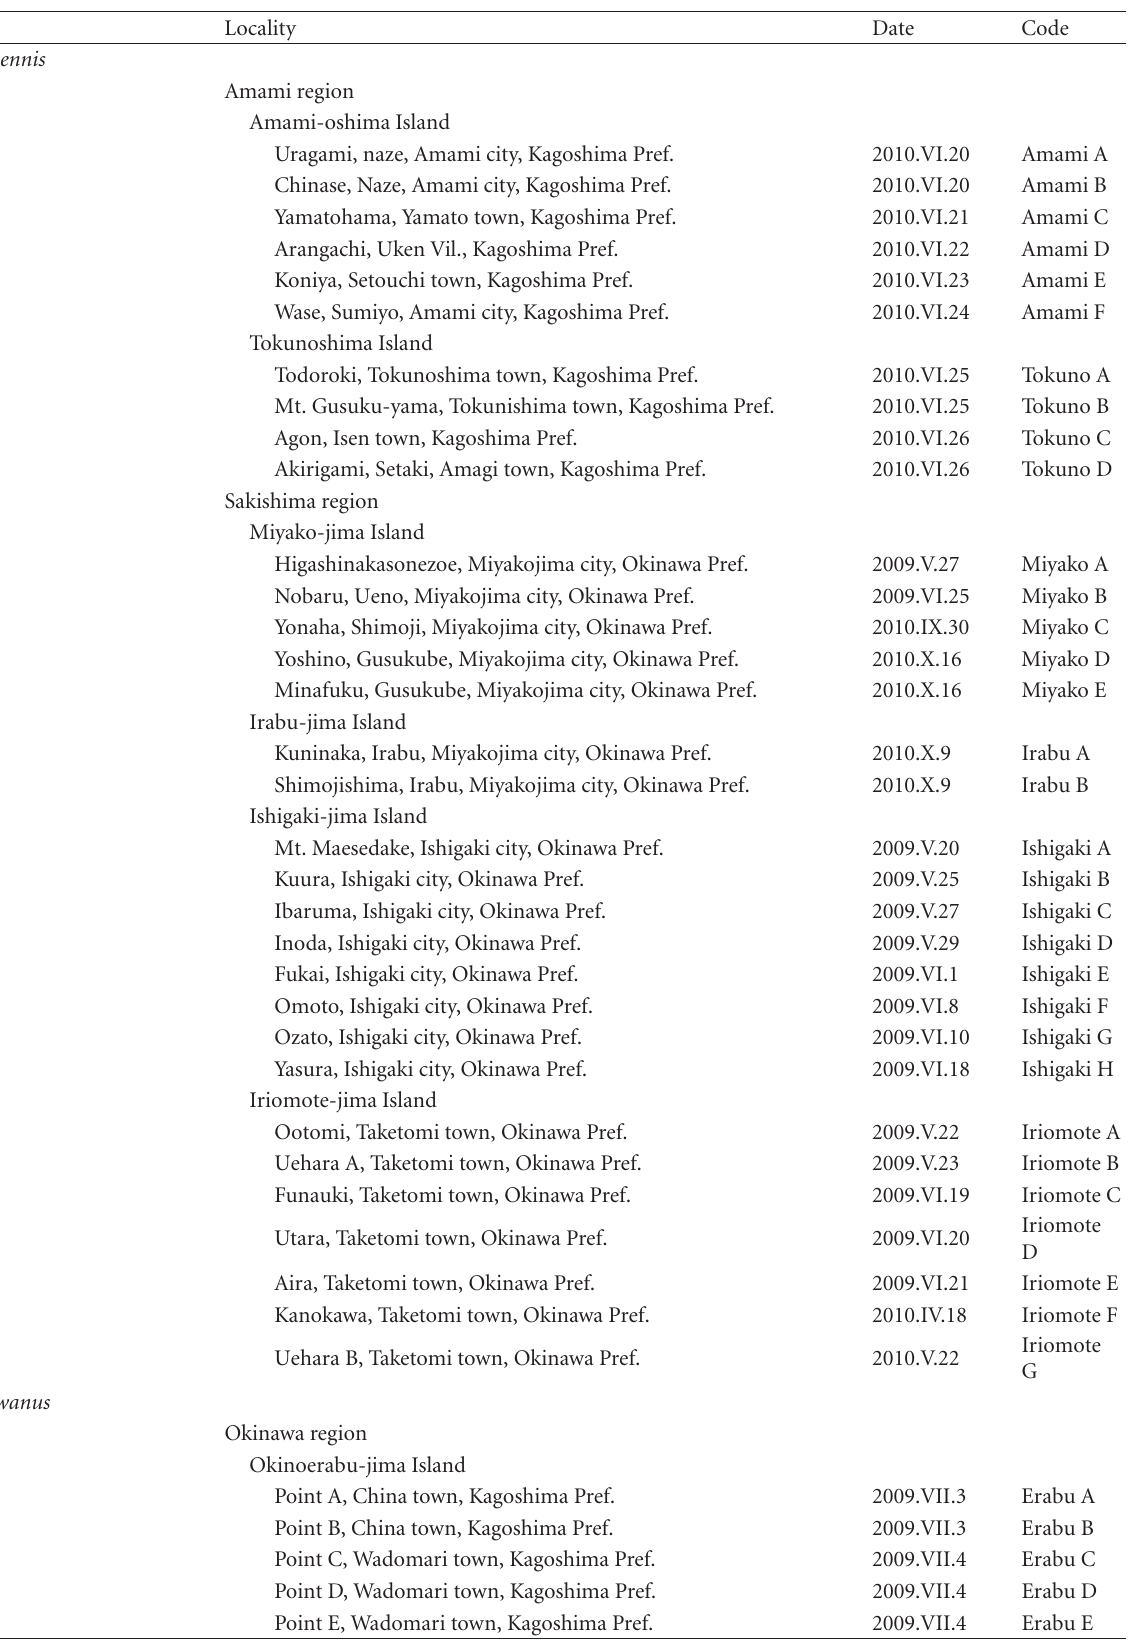
Table 1: Materials used in this